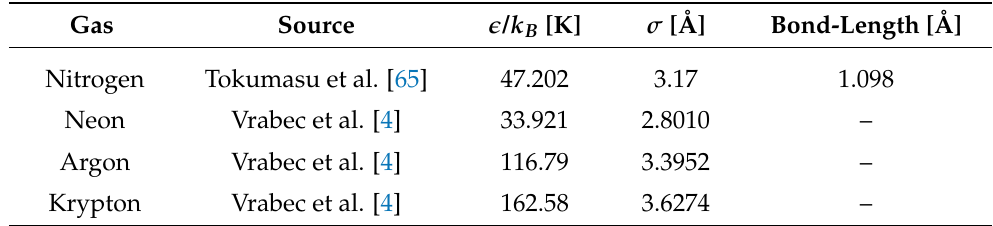
Table 1. Molecular models for nitrogen and noble